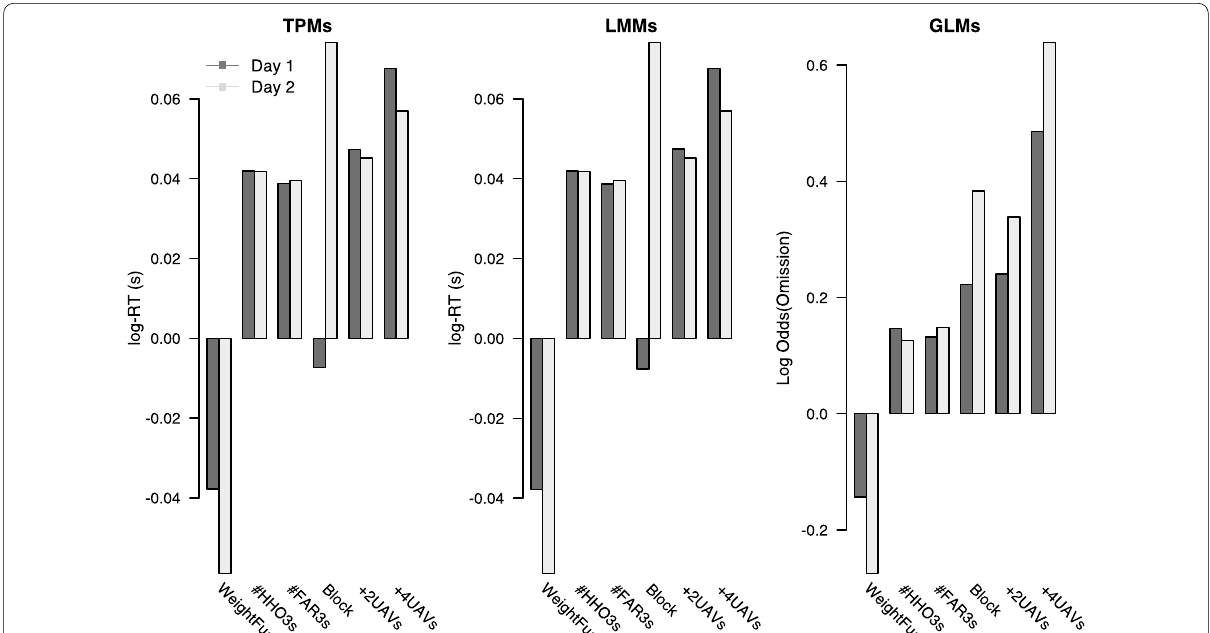
Fig. 13 Approximate effect size of different predictors on log-RT and log odds of omissions. Bars show the unstandardized beta weights from a log-normal TPM for response time (log-RT), from a LMM for response time (log-RT) and a GLM for log odds of omissions. Predictors WeightFuel, #HHO3s and #FAR3s were z-standardized within each